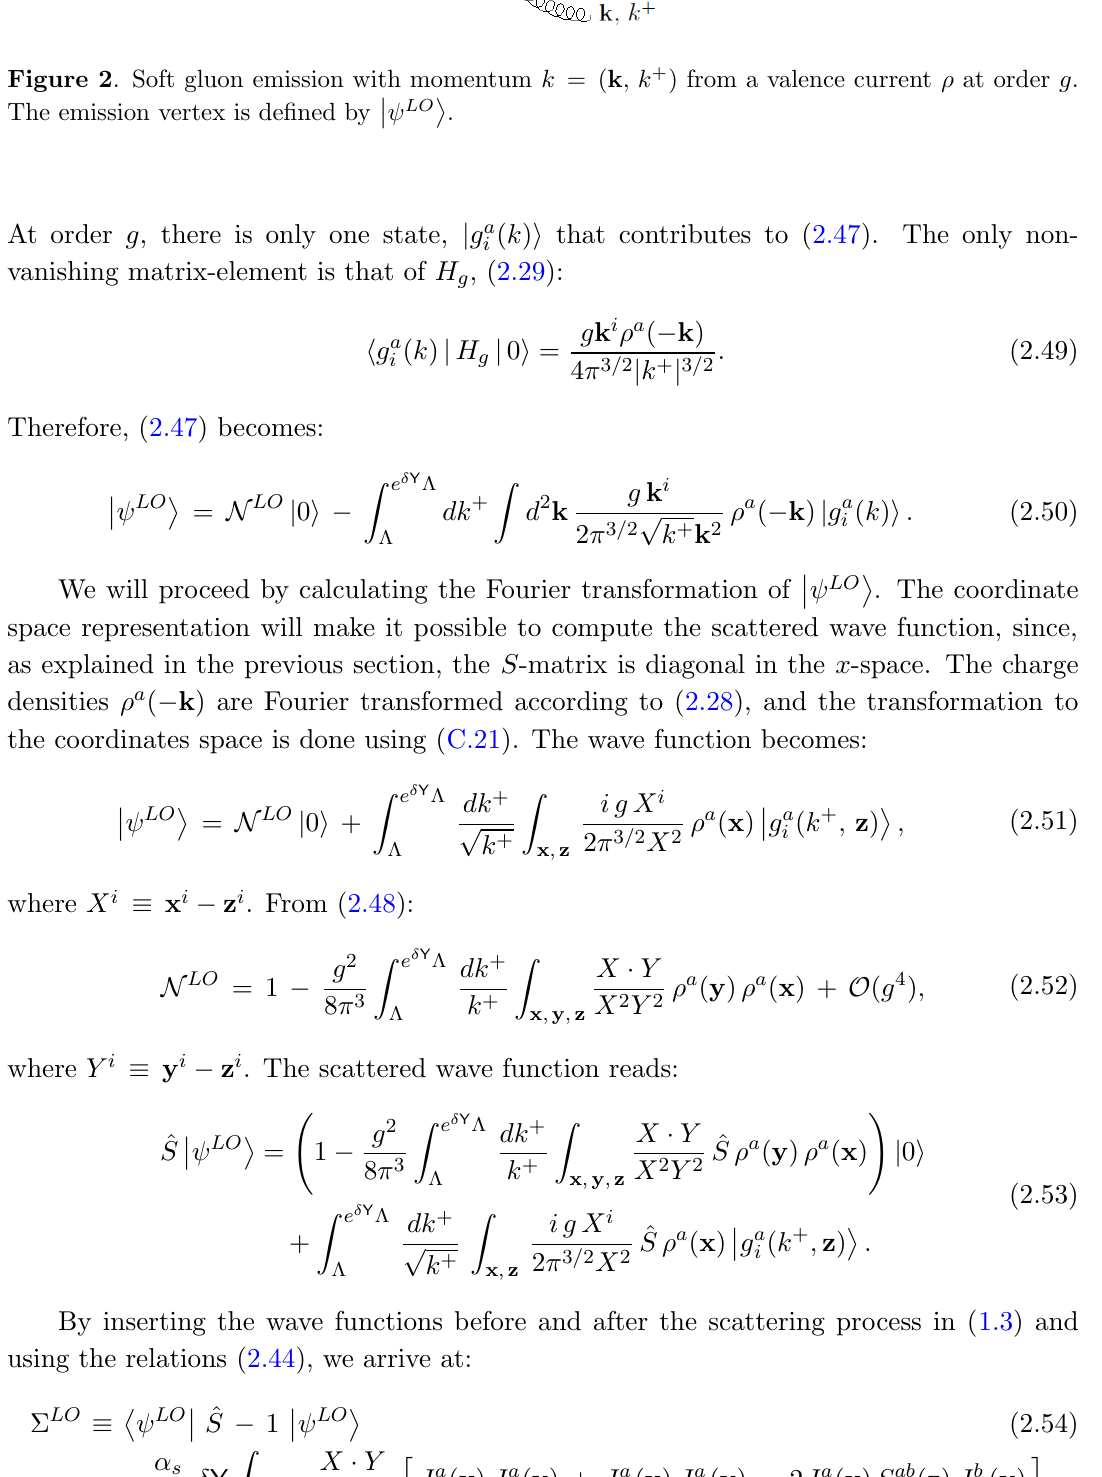
(cid:12) (cid:11) . (cid:12) LO